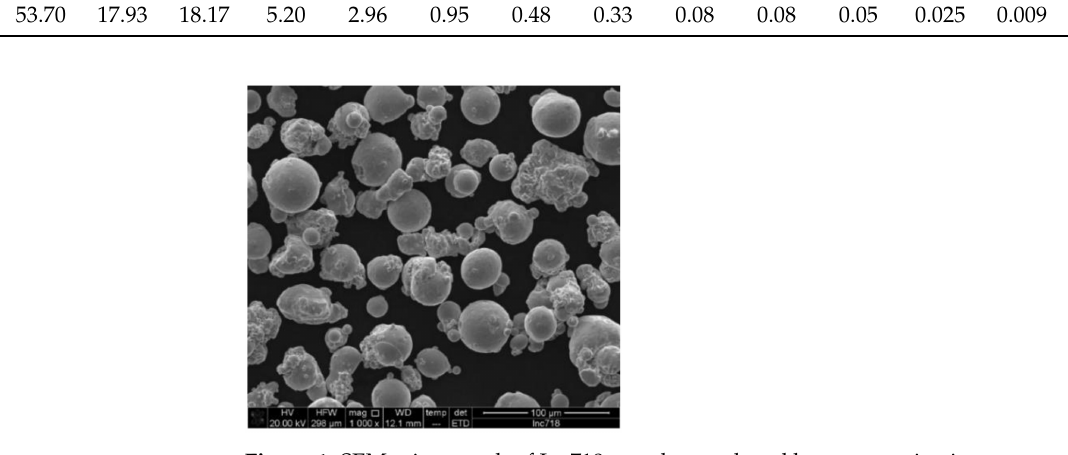
Figure 1. SEM micrograph of Inc718 powder produced by gas